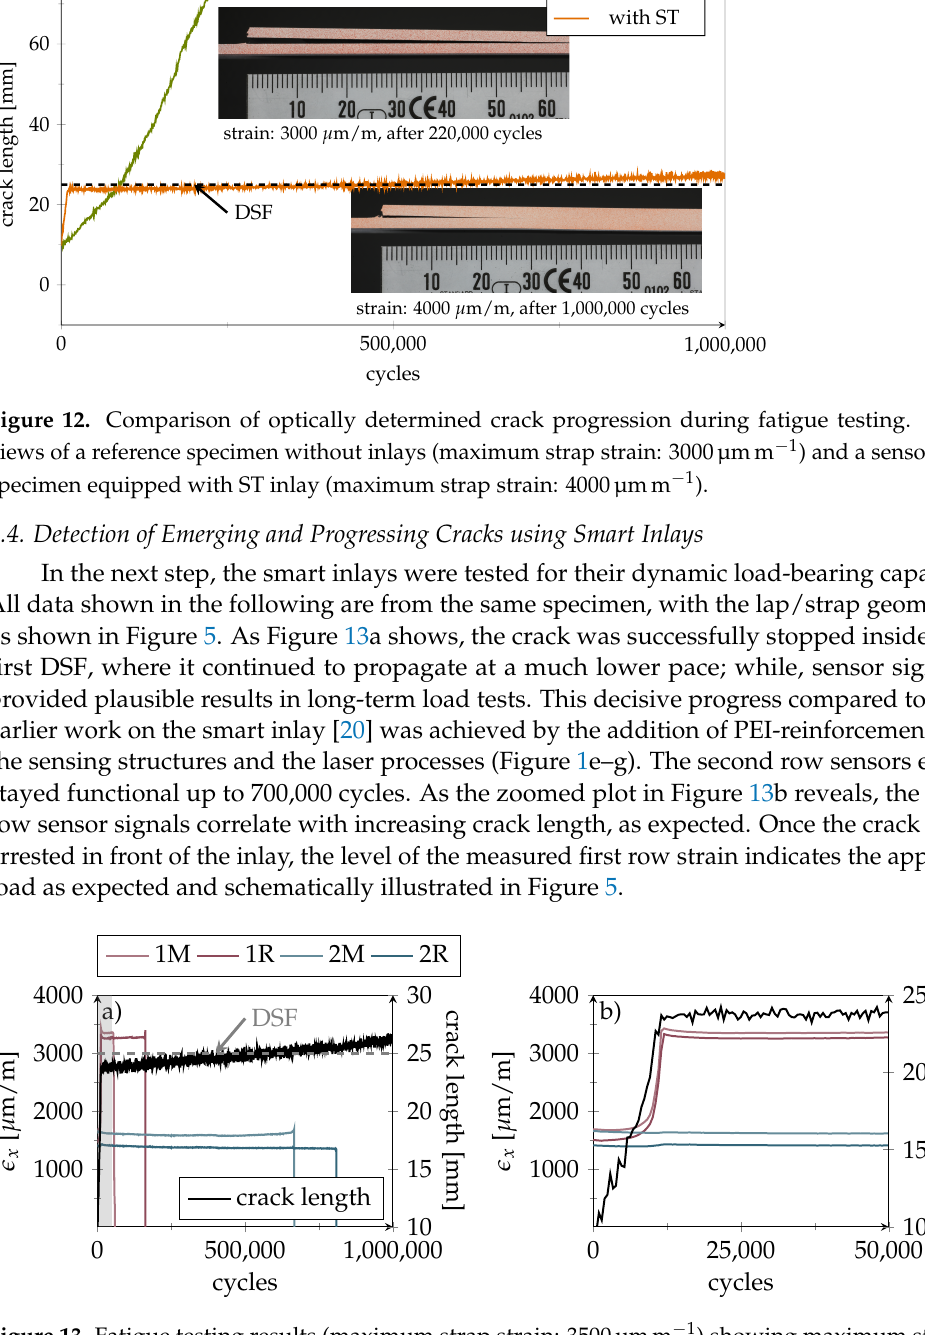
Figure 13. Fatigue testing results (maximum strap strain: 3500µmm − 1 ) showing maximum strain values over cycles as measured by the smart inlay sensors. Colors indicate first (red) and second sensor row (blue). Optically measured crack length is depicted black while gray dotted line marks the DSF edge ( a ) Crack advances quickly to the first DSF where it becomes arrested. First sensor row gets destroyed early while second row sensors remain functional almost till the cycle ends. Area of first 50,000 cycles is marked with grey background. ( b ) Zoom of the first 50,000 cycles of the left plot. Difference between first and second sensor row signals clearly correlates with the crack